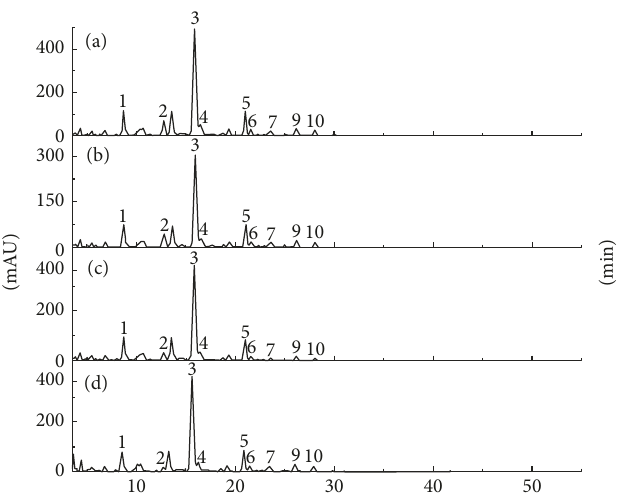
Figure 3: Chromatograms of lotus plumule from four di ff erent districts: (a) 30% part for XT; (b) 30% part for WY; (c) 30% part for JN; (d) 30% part for